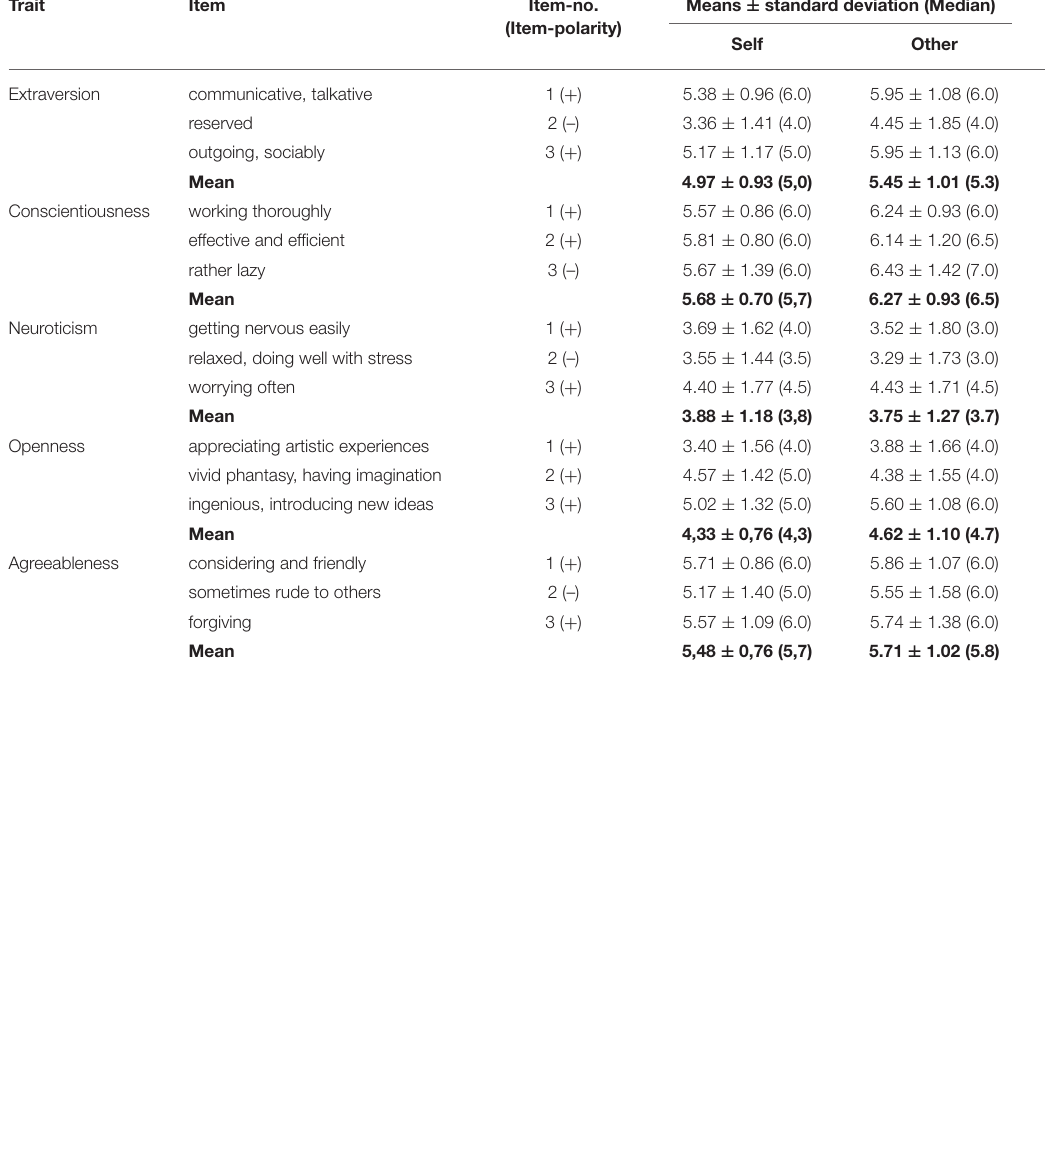
TABLE 5 | Means, standard deviation, medians, inter-rater-, and inter-item correlations ( r S, * p ≤ 0.05, ** p ≤ 0.01) of the big-five traits based on the BFI-S for intensive pig keepers ( N = 42). Trait Item Item-no.